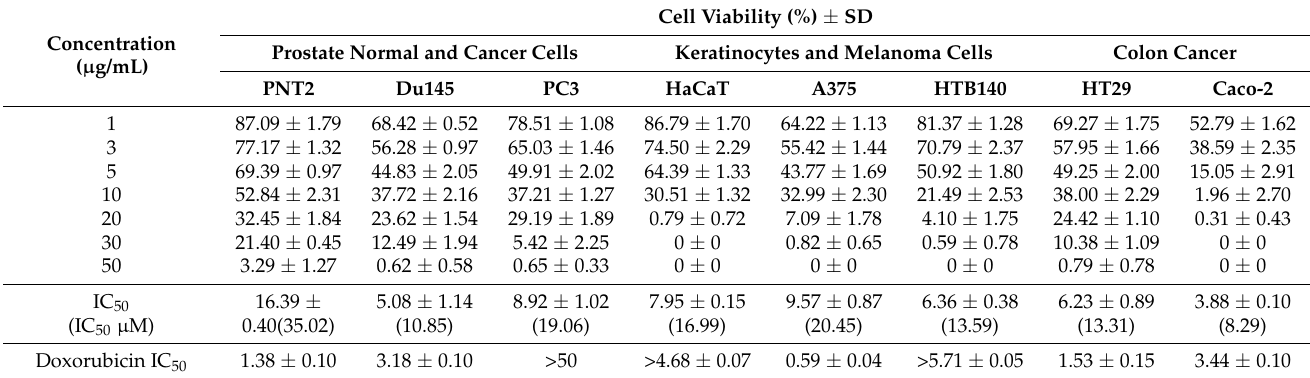
Table 1. Viability of normal and cancer cell lines treated for 24 h with 1–50 µ g/mL of 3 (values are means of three measurements ± SD).